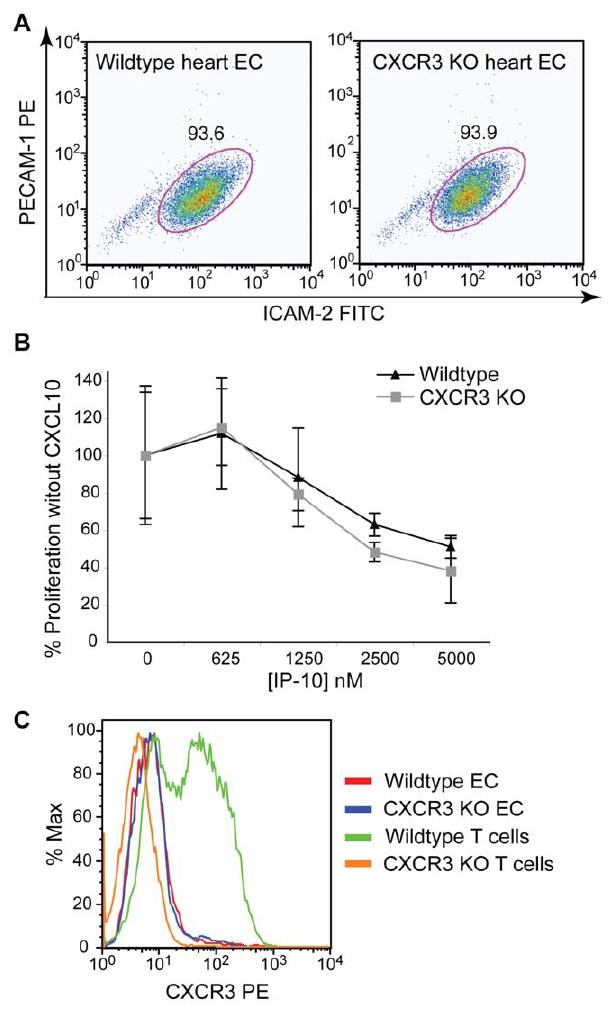
Figure 2. CXCL10 inhibits proliferation of CXCR3-deficient murine endothelial cells. A) Endothelial cells were isolated from hearts of wildtype and CXCR3-deficient (CXCR3 KO) mice and purity was determined by flow cytometry using antibodies against ICAM-2 and PECAM-1. Endothelial cells of at least 85% purity were used for all experiments. B) CXCL10’s anti-proliferative effect was assessed as described for Figure 1. Representative data of at least three experiments are shown, each performed in triplicate, data are mean 6 SD. C) CXCR3 expression of primary endothelial cells and activated T cells was assessed by flow cytometry. Wildtype heart endothelial cells did not express CXCR3, whereas activated wildtype T cells expressed high levels of